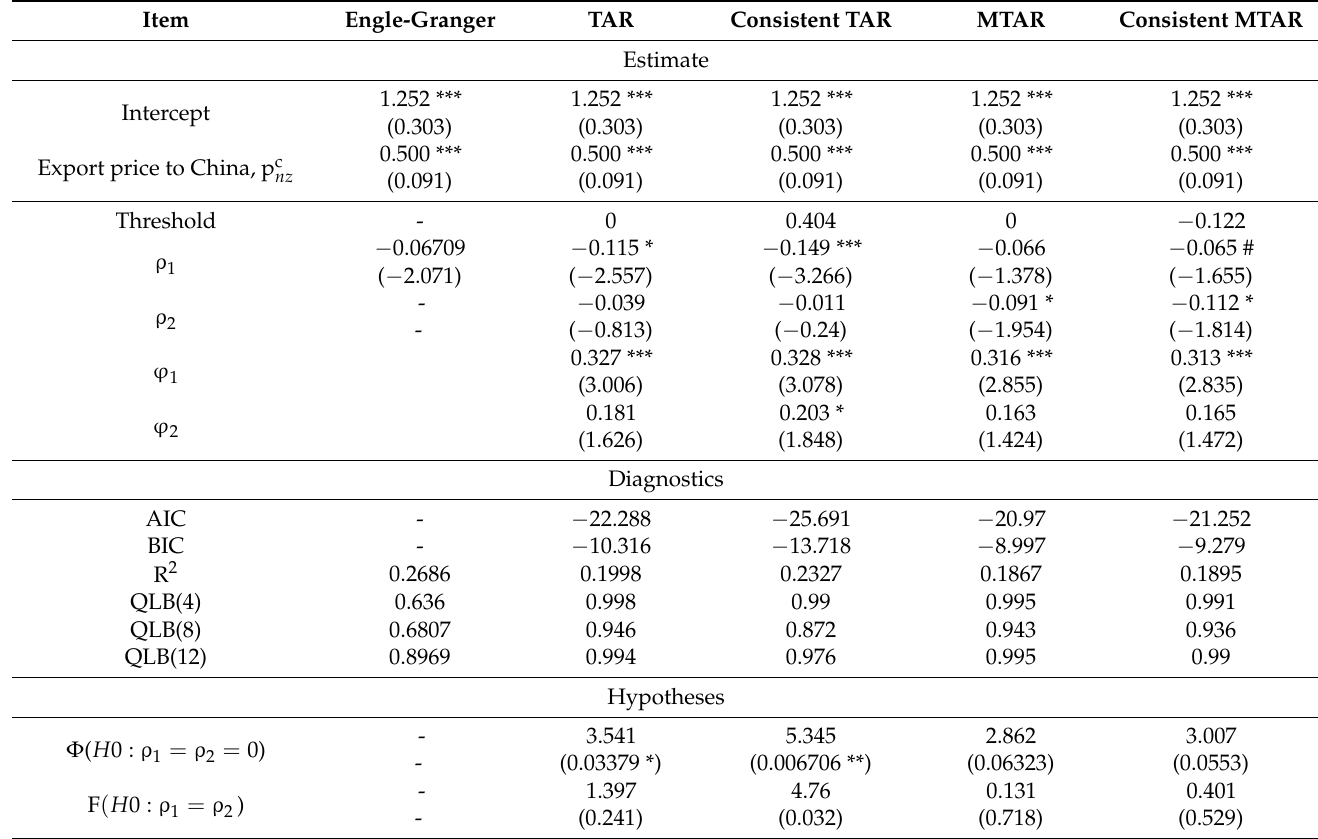
Table 5. Results of Engle-Granger and threshold cointegration tests for New Zealand SMP export prices.